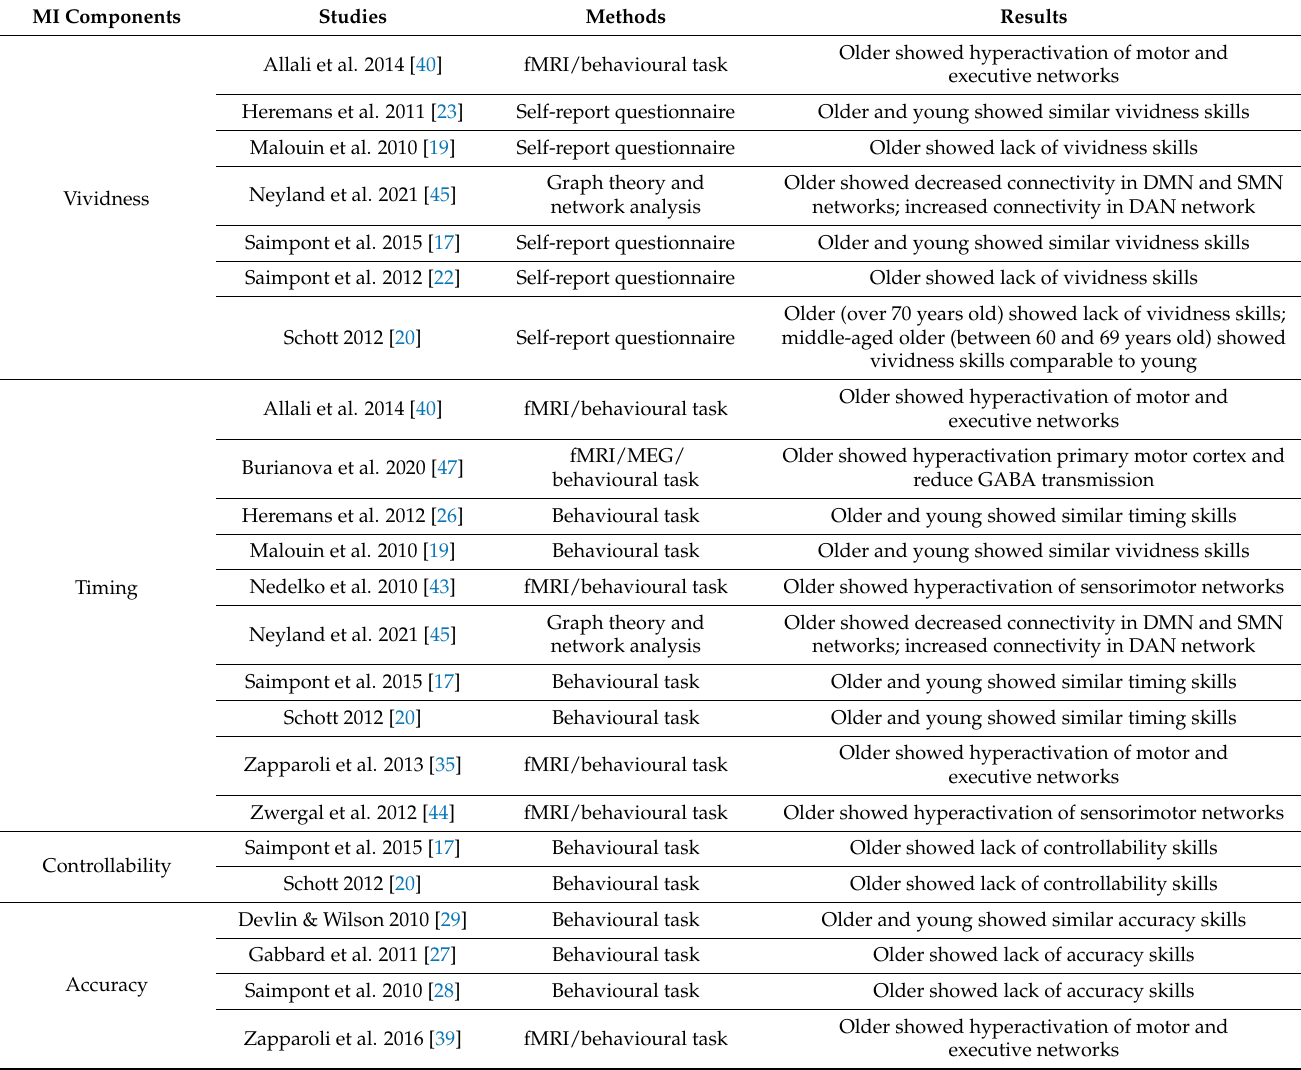
Table 1. Sum of the studies included in the review. Abbreviation: DMN = default mode network; SMN = sensorimotor network; DAN = dorsal attention